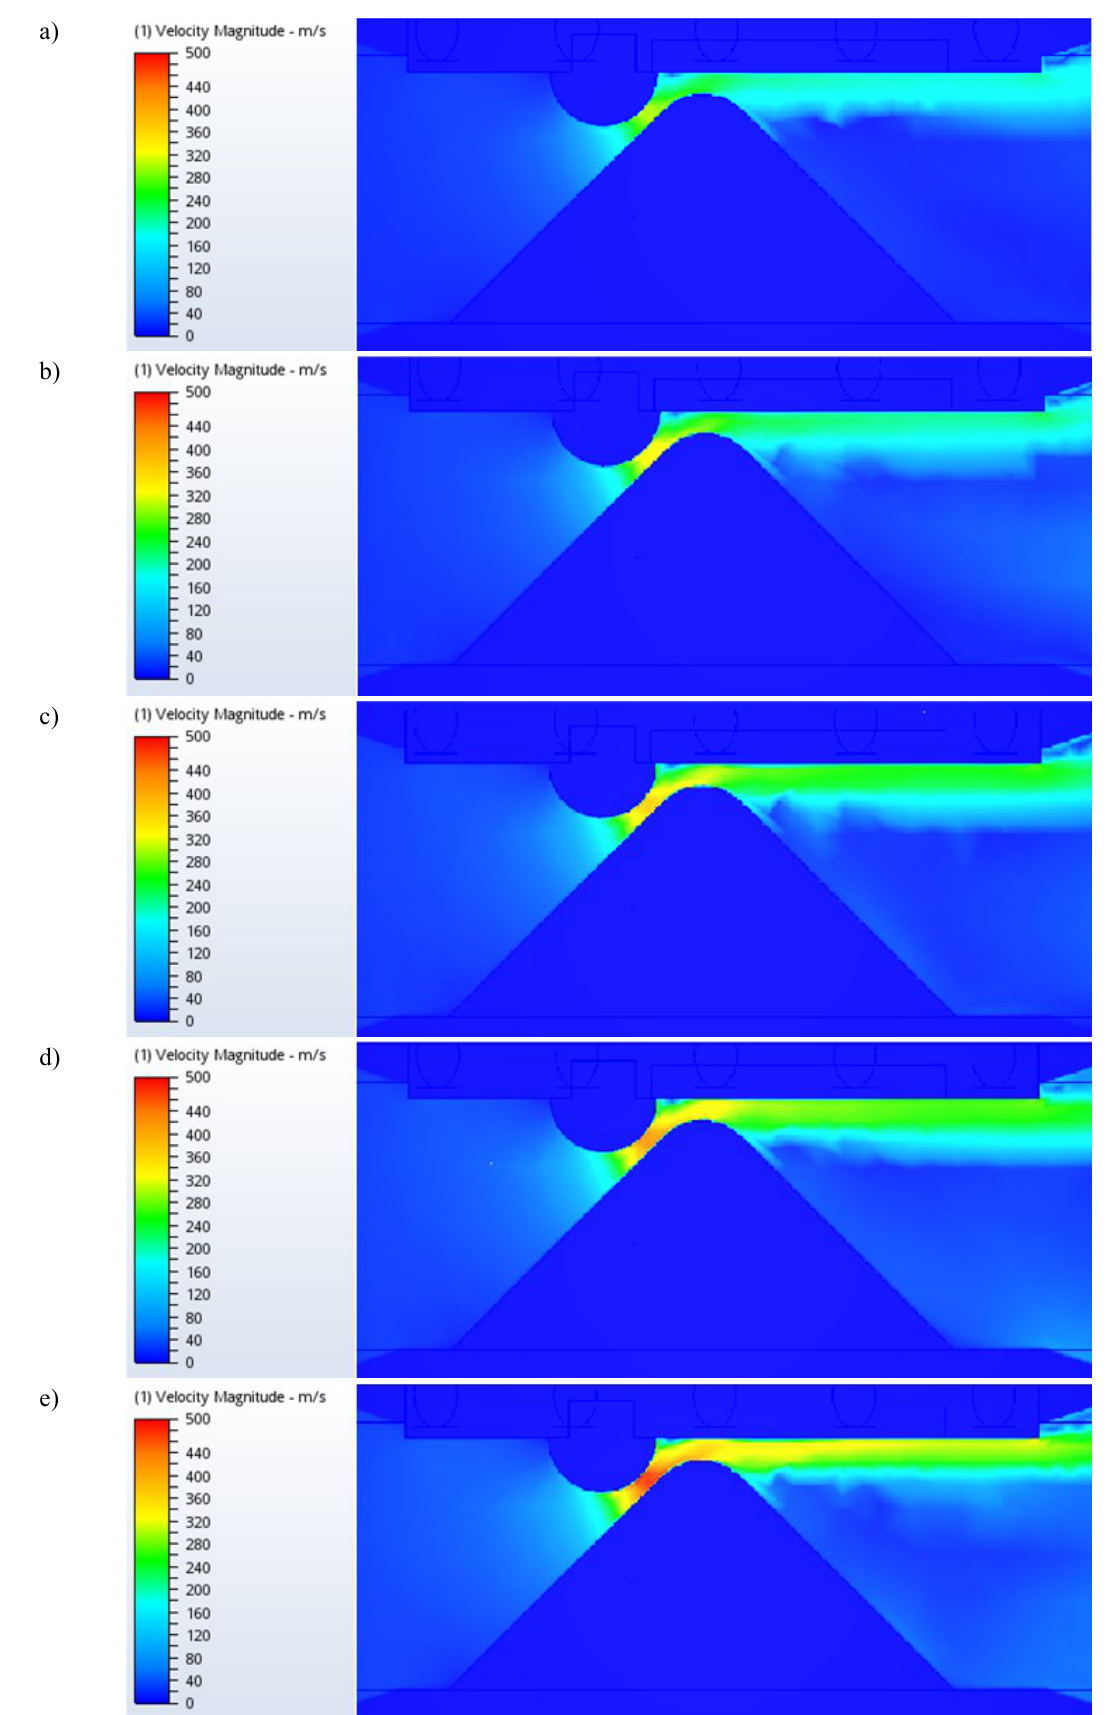
Fig. 6. The results of the velocity in the tunnel for the flow rate in the tunnel inlet: a) 7,74 m/s, b) 8,85 m/s, c) 9,95 m/s, d) 11,06 m/s, e) 12,16